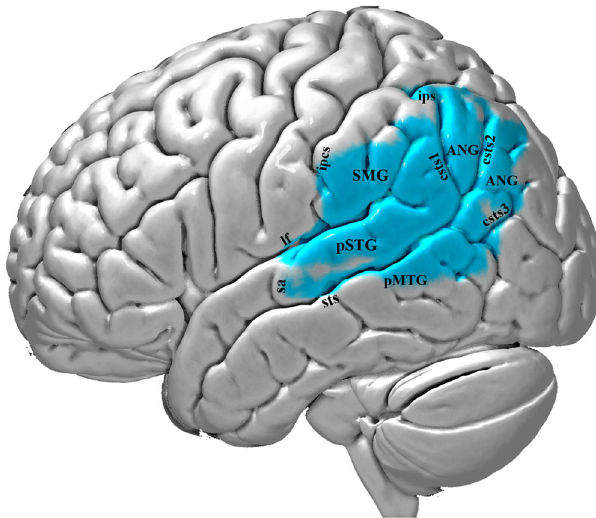
Fig. 4 Lateral view of the left hemisphere lesion of patient MM with damage to the dorsal posterior language region. The area affected by the lesion is marked with the blue color. The lesion includes the posterior temporal region, i.e. clearly posterior to the level of the sulcus acousticus (sa). It also includes the Heschl ’ s gyrus (HG) region, which lies within the lateral fi ssure, and a part of the posterior middle temporal gyrus (pMTG). Thus, the posterior temporal region (Wernicke ’ s area) is damaged. The lesion extends to the supramarginal (SMG) and angular (ANG) gyri of the inferior parietal lobule. Thus, the lesion is restricted to the dorsal posterior language network, sparing all cortical areas associated with the ventral language network, i.e. the anterior to intermediate temporal areas and their connections via the TFexcF to area 45 on the IFG. The lesion was reconstructed in MNI stereotaxic space and projected on the